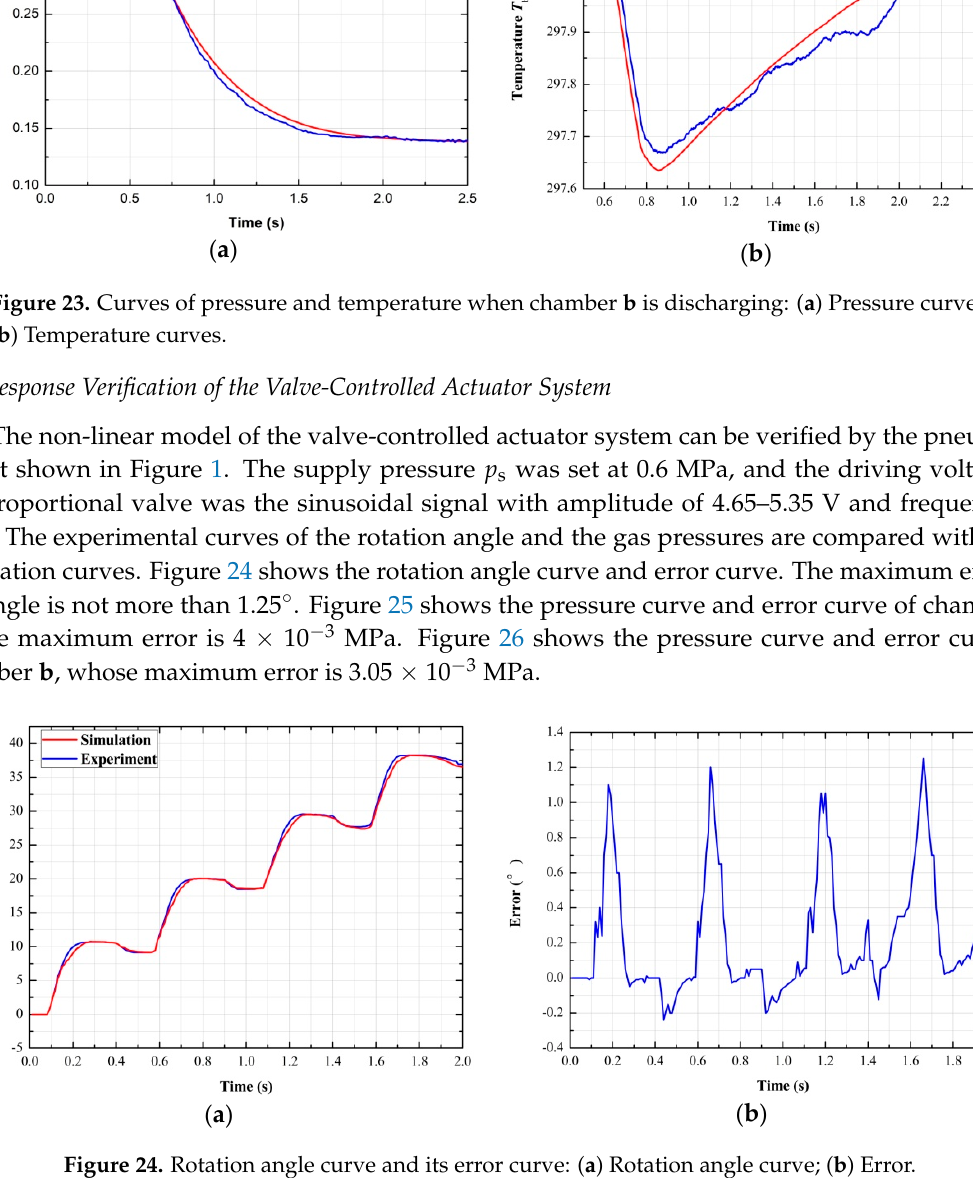
( b ) Figure 25. Pressure curve of chamber a and its error curve: ( a ) Pressure curve; ( b ) Error. ( a ) ( b ) Figure 26. Pressure curve of chamber b and its error curve: ( a ) Pressure curve; ( b ) Error. 7. Conclusions In this paper, the mass flow rate equations of the proportional directional control valve were derived from throttled flow and clearance flow by taking into account the clearance between the valve spool and the sleeve. In the modeling of the valve-controlled actuator system, the heat transfer formula was used to the derivation of the energy equation, and the Stribeck model was applied to